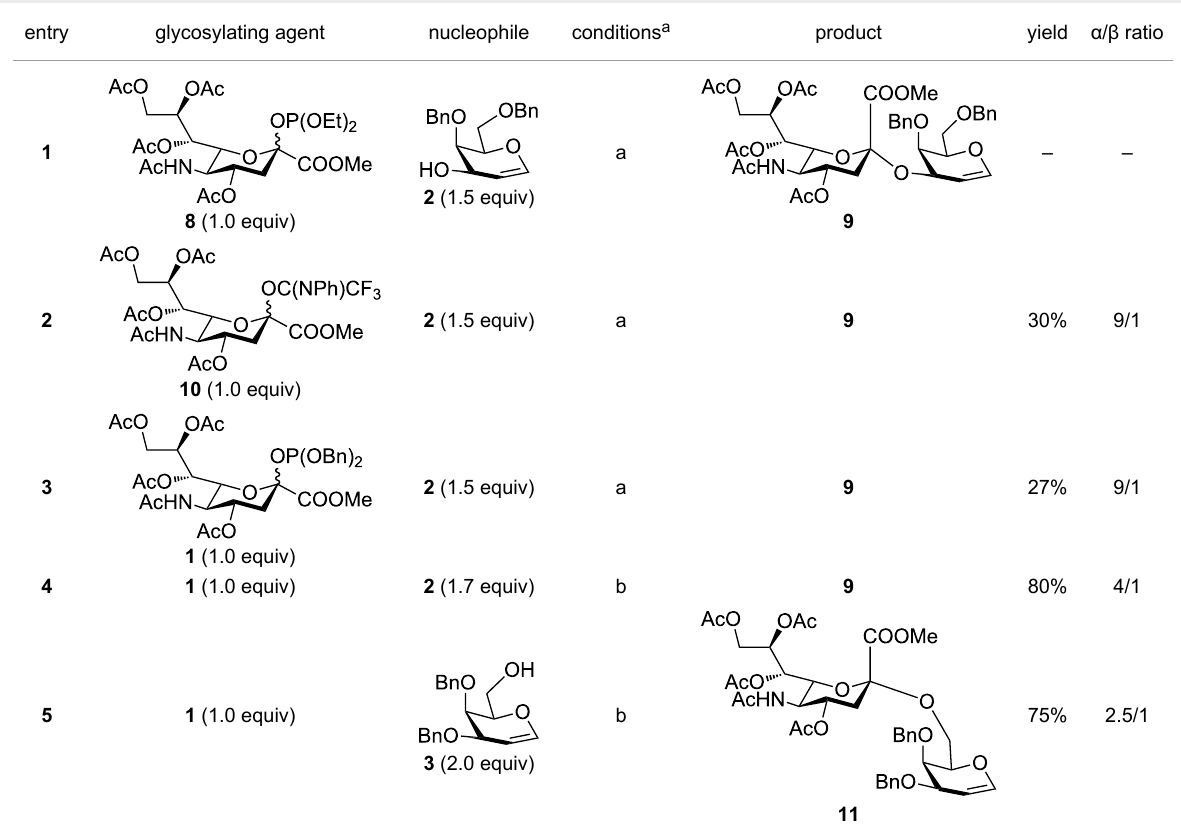
Table 1: Synthesis of building blocks 9 and 11